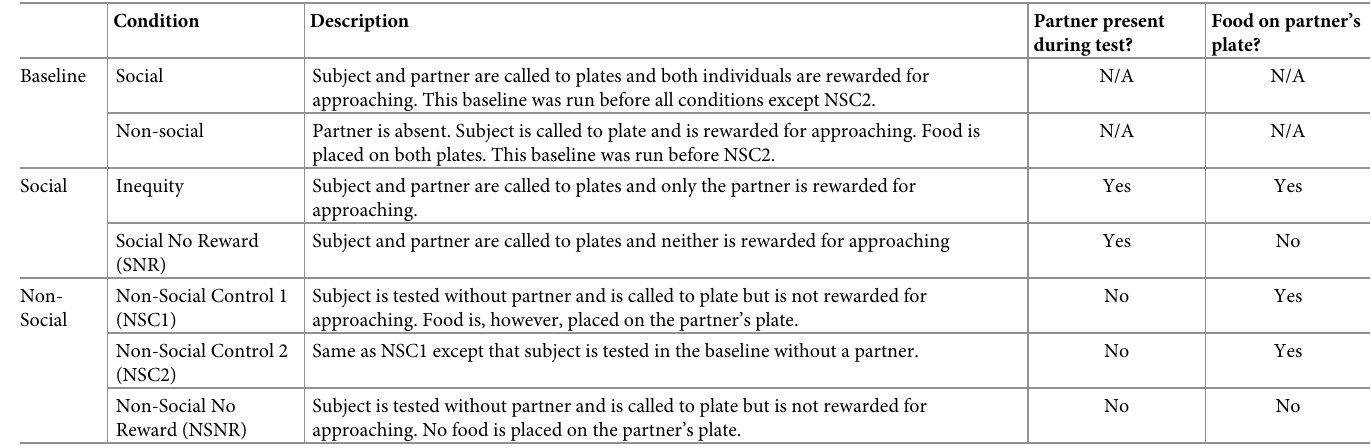
Table 1. Description of conditions administered in the test half of sessions. Prior to the test half, subjects were tested in a baseline condition where, with one exception, both subject and partner were rewarded for approaching the plate. In the Non-Social Control 2 (NSC2) condition, the baseline was run in the absence of a partner dog and thus food was simply placed on the partner’s plate. Food was always absent from subjects’ plates during tests. A single unit of reward (note that reward type varied between dogs and dingoes) was used in all